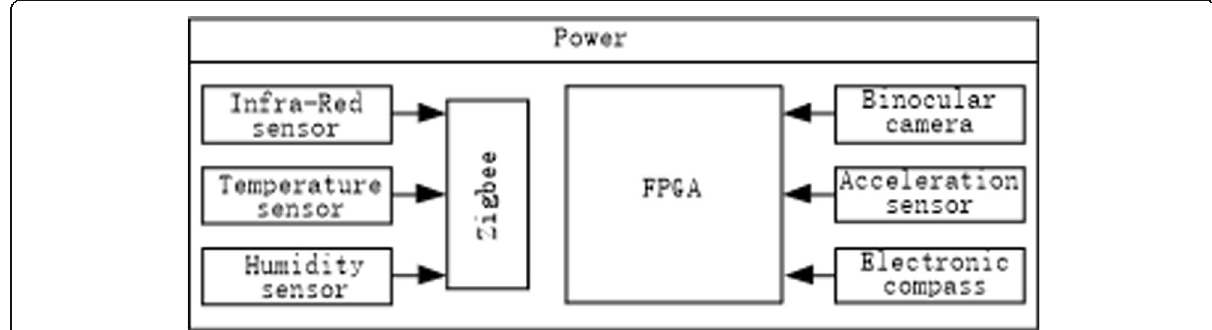
Fig. 1 Whole framework of wireless multimedia sensor